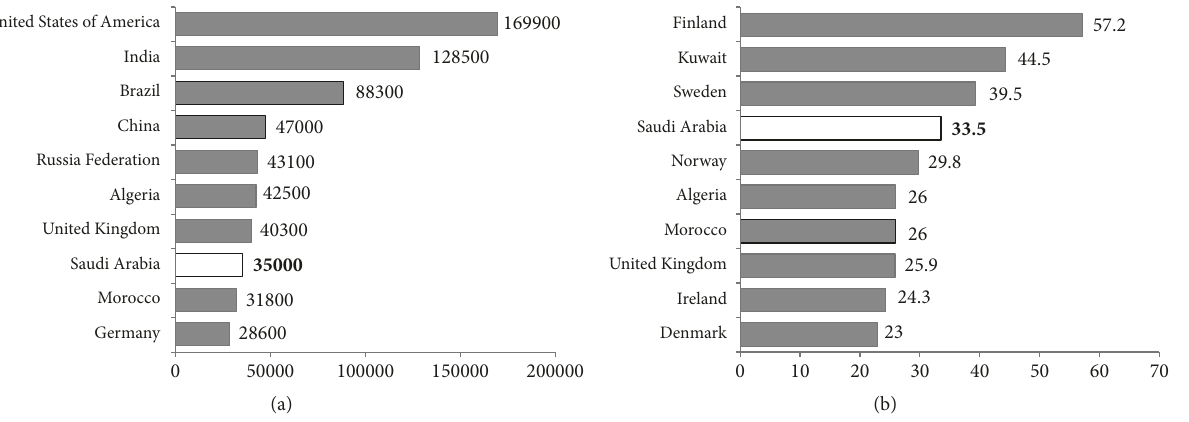
Figure 1: (a) Top ten countries/territories for number of children and adolescents with type 1 diabetes ( < 20 years). (b) Top ten countries/territories for the incidence rates of type 1 diabetes ( < 20 years) per 100,000 children per year, 2017